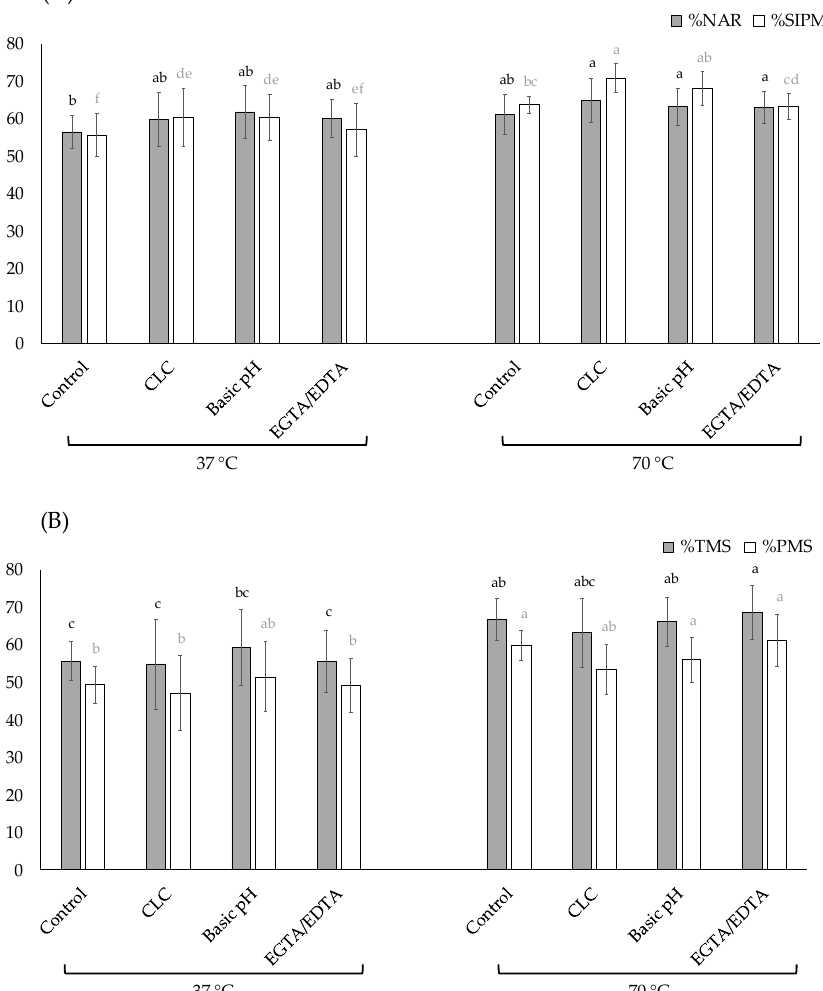
Figure 5. Evaluation of different modifications in the thawing extenders. Data are expressed as mean ± standard deviation. ( A ) Effect on normal acrosomal ridge (%NAR) and sperm with intact plasma membrane (%SIPM). a, b, c, d, e, f indicate significant differences between treatments ( p < 0.05); black letters are within %NAR and grey letters within %SIPM. ( B ) Effect on total motile sperm (%TMS) and progressive motility sperm (%PMS). a, b, c indicate significant differences between treatments ( p < 0.05), and black letters are within %TMS and grey letters within